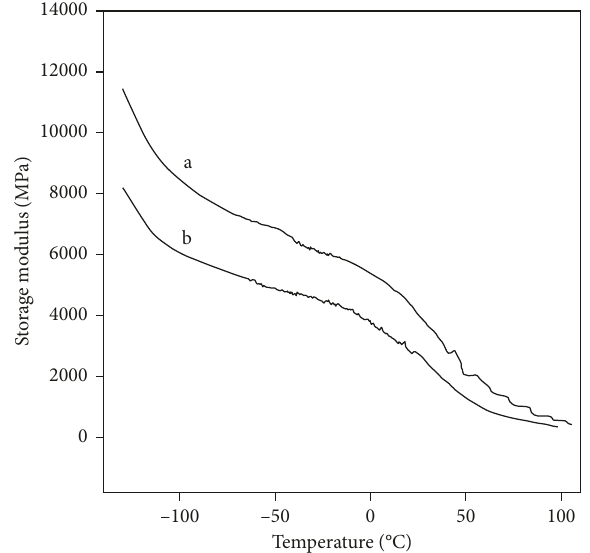
Figure 3: DMA analysis of polymer nanocomposites with 2.5wt.% CNT (b) compared with the control